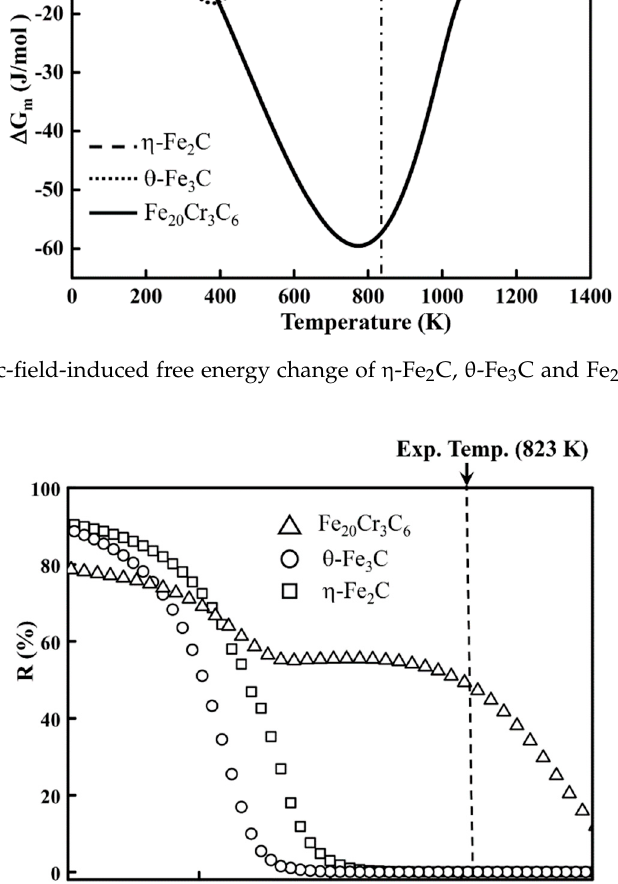
Figure 10. The major controlling factors of η -Fe 2 C, Fe 3 C and Fe 20 Cr 3 C 6 with the 12 T magnetic field.